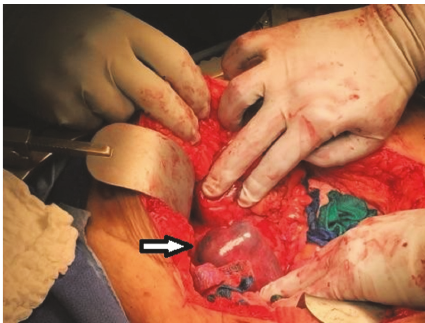
Figure 2: Intraoperative photo. Arrow highlights cystic mass in